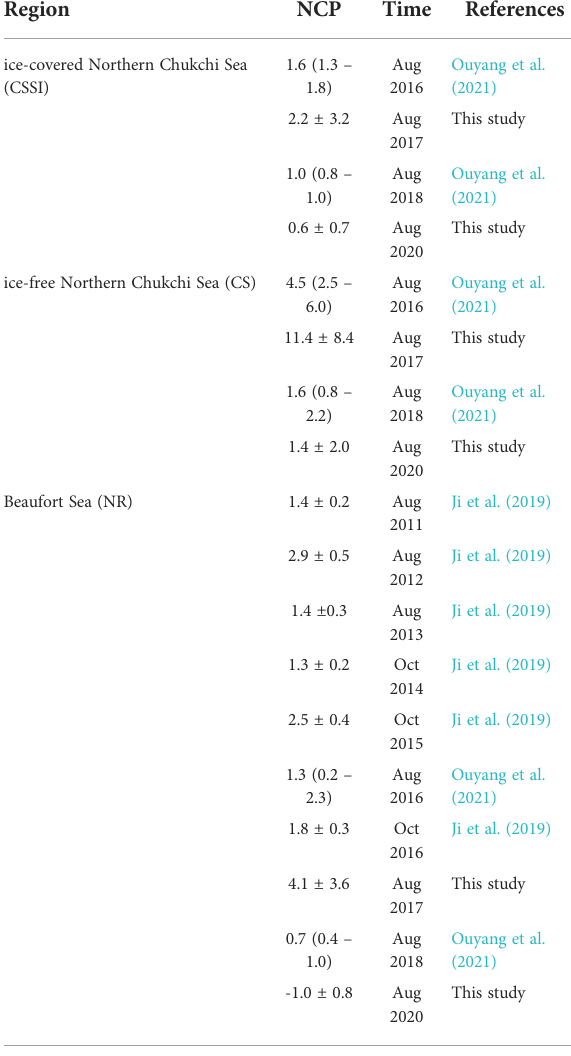
TABLE 2 NCP estimates (mmol O 2 m -2 d -1 ) in the Northern Chukchi and Beaufort Seas. Region